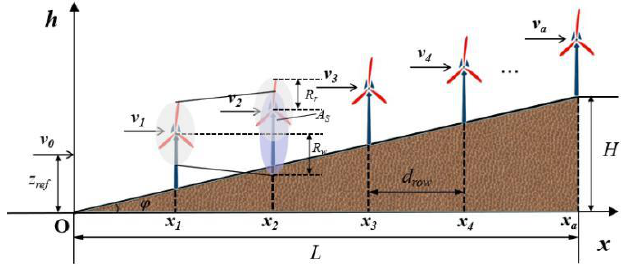
Figure 5. Illustration of WTs’ wake over a hill with moderate gradient.